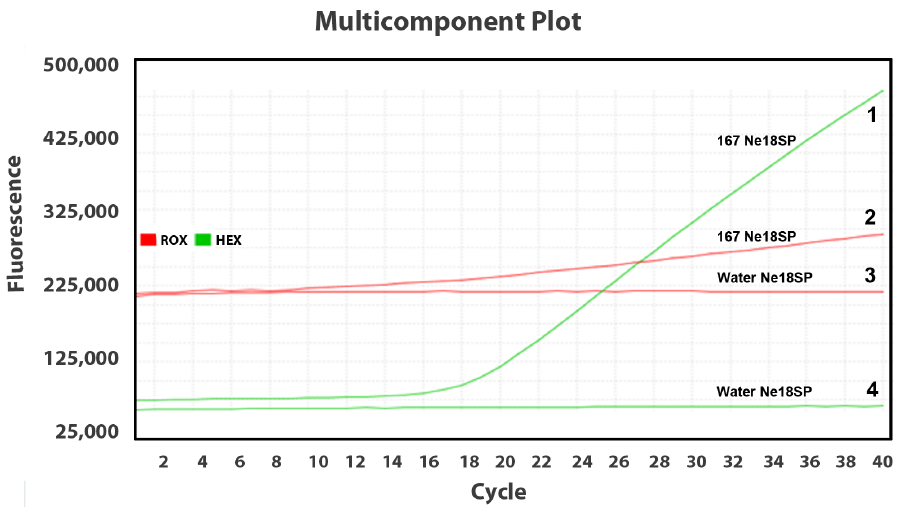
Figure 5. Multi-component plot of a real-time-PCR result. This plot shows increased reference dye ROX (Curve 2) and non-increased ROX (Curve 3), increased reporting dye HEX (Curve 1) and non-increased HEX (Curve 4) for Bursaphelenchus mucronatus (sample 167, Curves 1 and 2) and negative control (Curves 3 and 4).